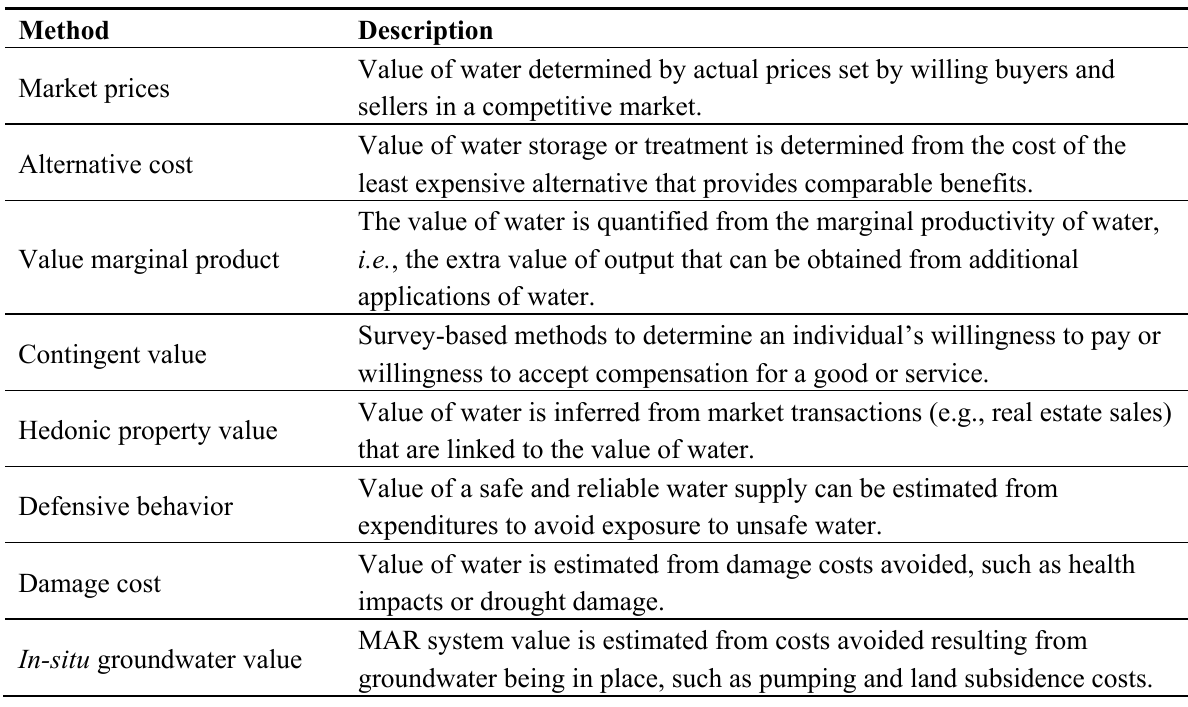
Table 1. Methods to monetize benefits of managed aquifer recharge (MAR)